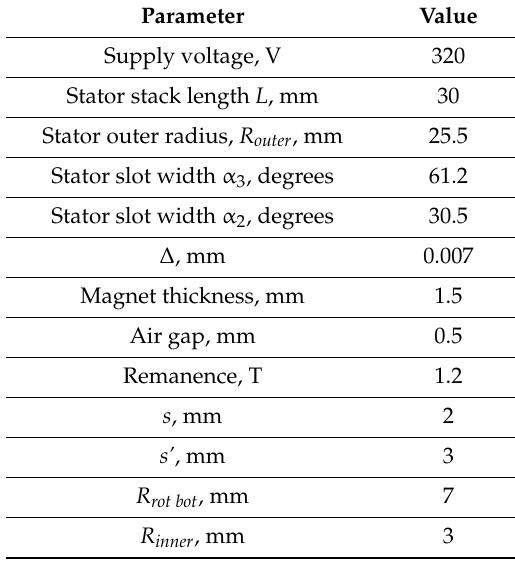
Table 2. The FRM (flux reversal machine) parameters fixed during the optimization.